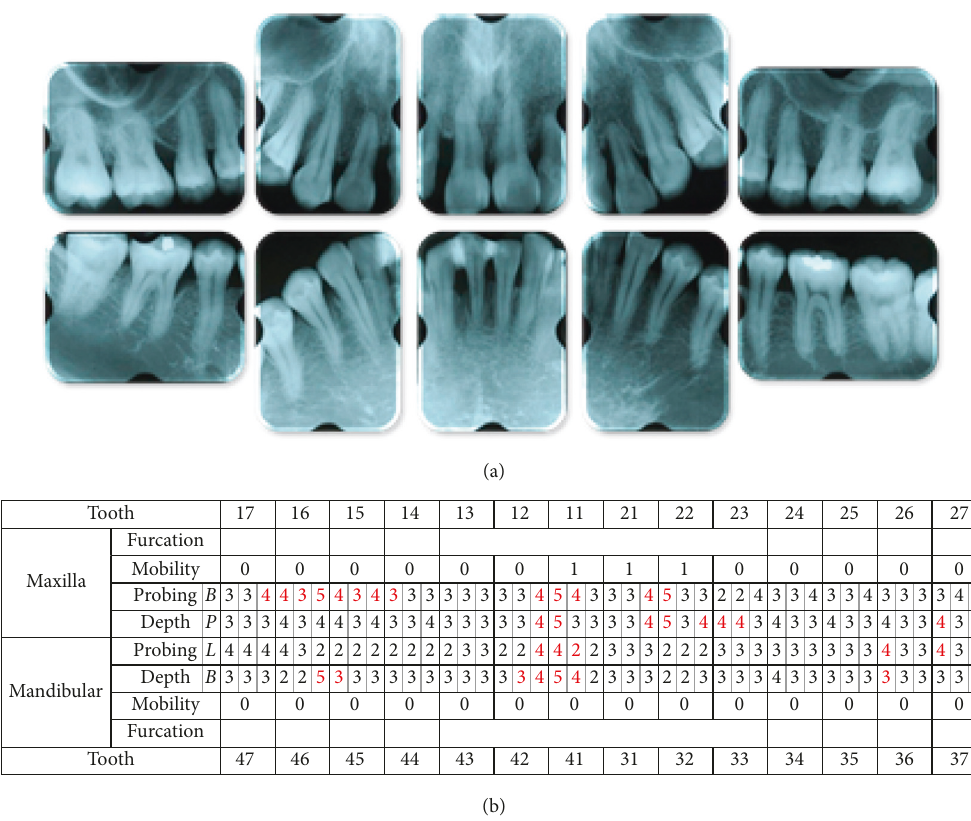
Figure 3: Pre-orthodontic treatment dental radiographs (a) and periodontal examinations (b) are shown. The red color indicates bleeding on probing.